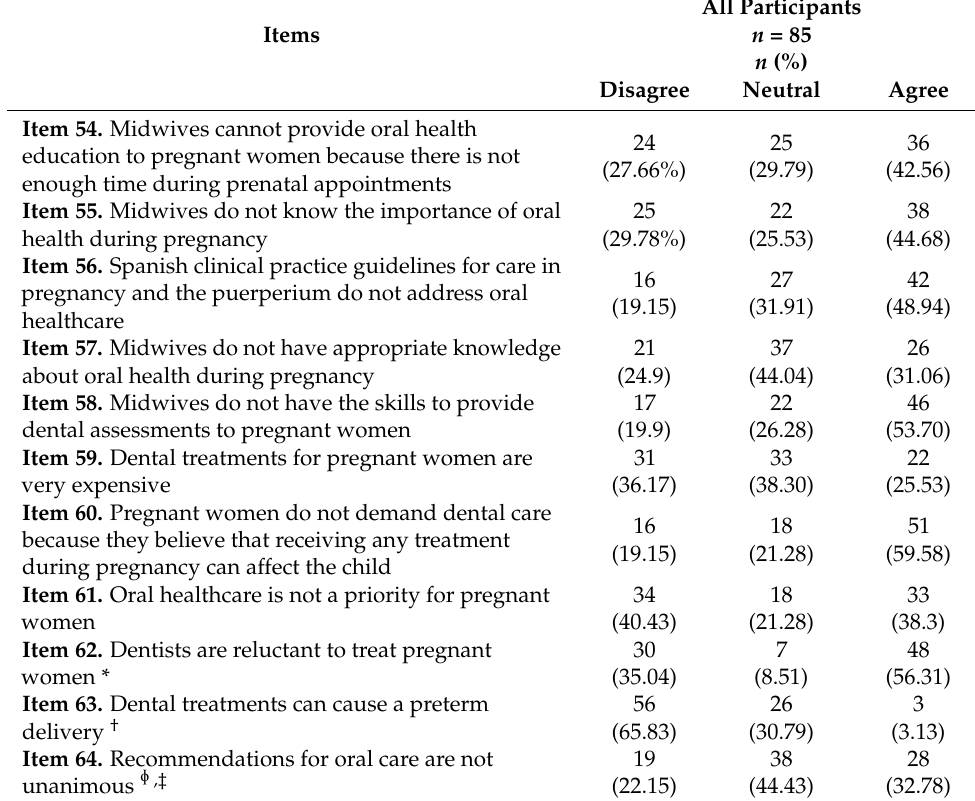
Table 5. Barriers to oral health promotion during pregnancy.